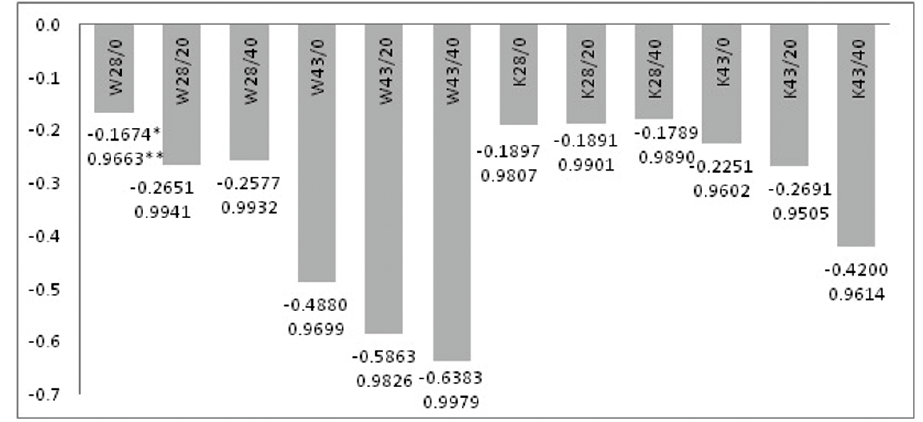
Figure 9. Values of the slope coe ffi cient of the straight line, determined from the linear relationship for the cooling process in the time range 0–30s (* coe ffi cient of slope of the straight line, ** linear correlation coe ffi cient).